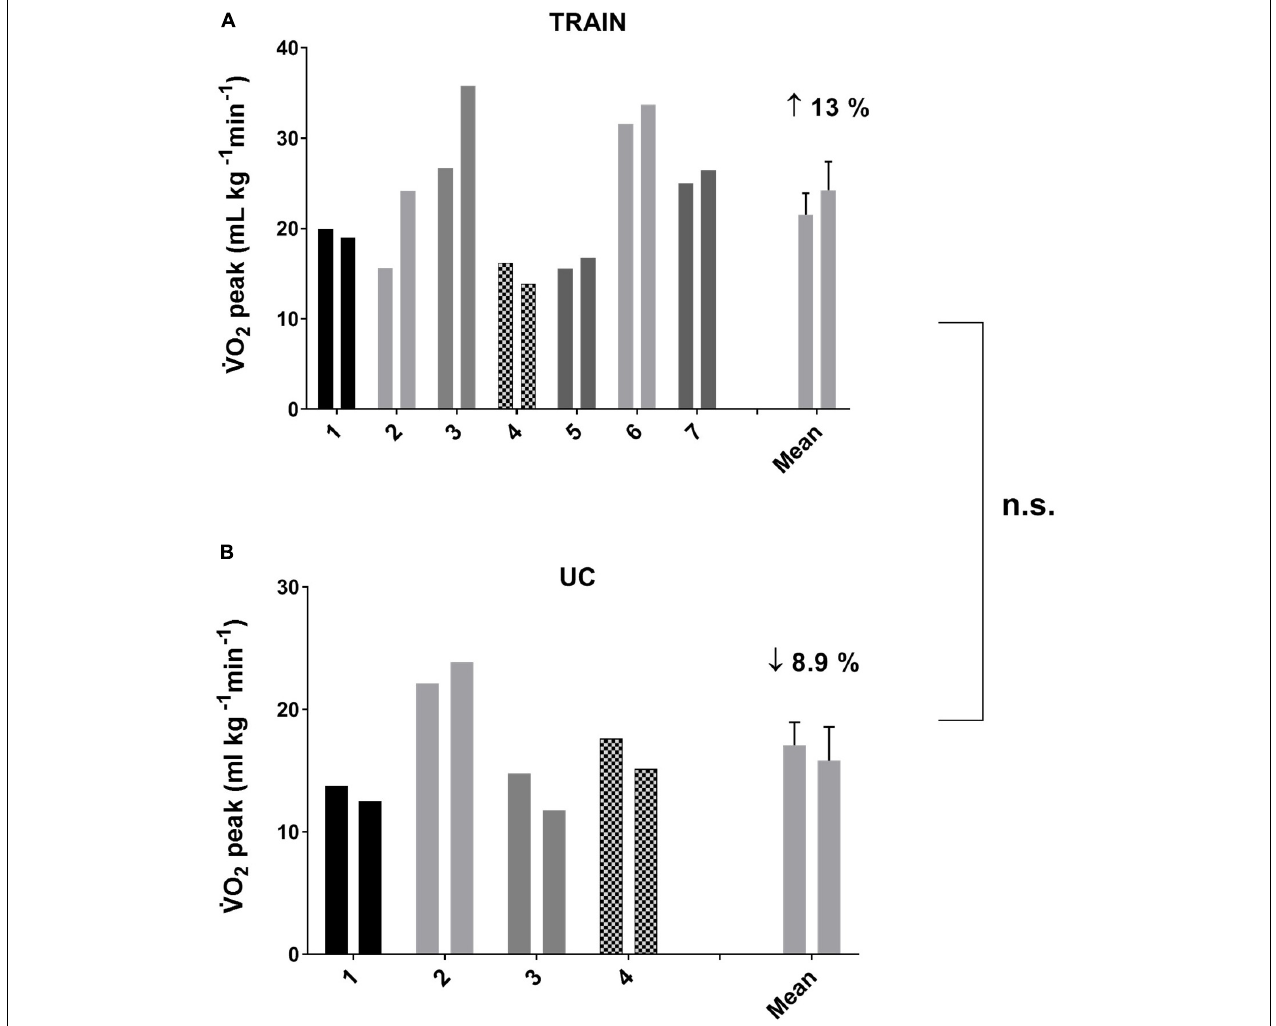
FIGURE 2 | Individual and average values for peak oxygen uptake (˙VO 2peak ) before and after 12 weeks of exercise training ( A , TRAIN) and usual care ( B , UC). Average data are expressed as mean + SE. n.s., not significantly different between TRAIN and